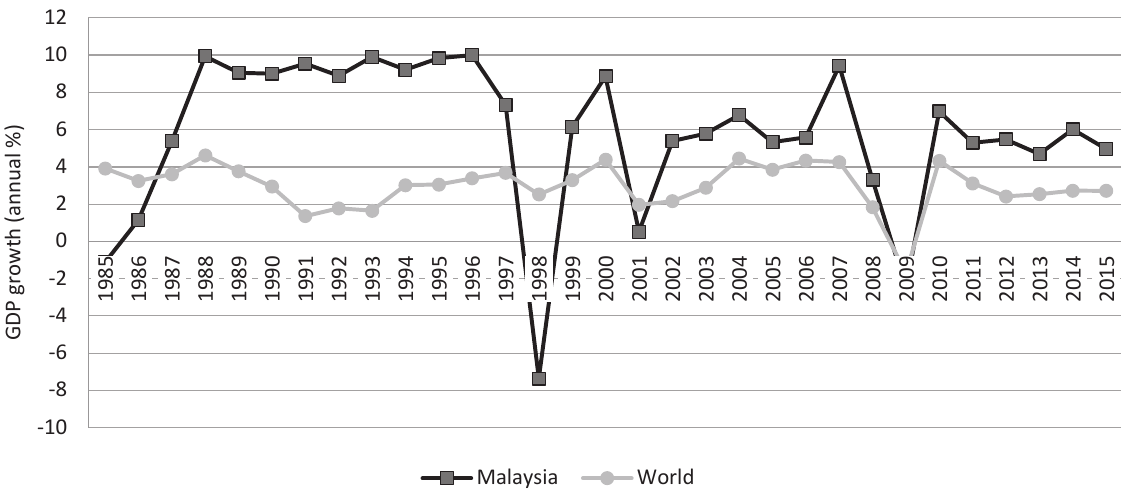
Source: World Development Indicators